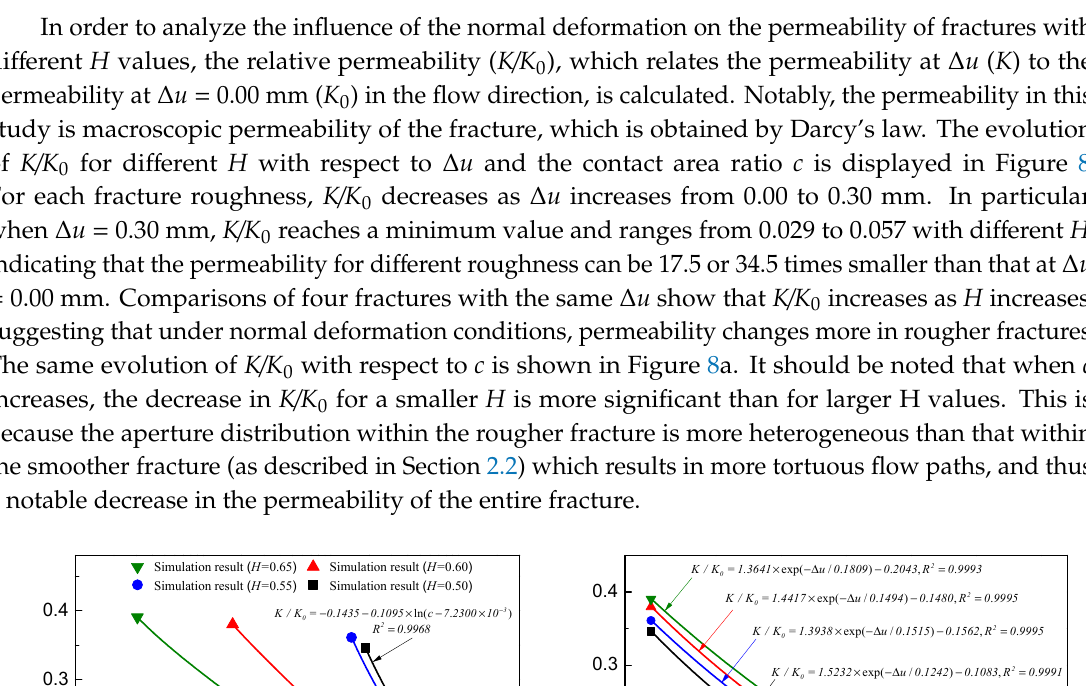
Figure 7. Variations of pressure fields and flow streamlines for fractures of different Δ u with H = 0.50: ( a – c ) are pressure fields (unit: Pa); and ( d – f ) are flow streamlines. ( a – c ) are pressure fields (unit: Pa); and ( d – f ) are flow streamlines.